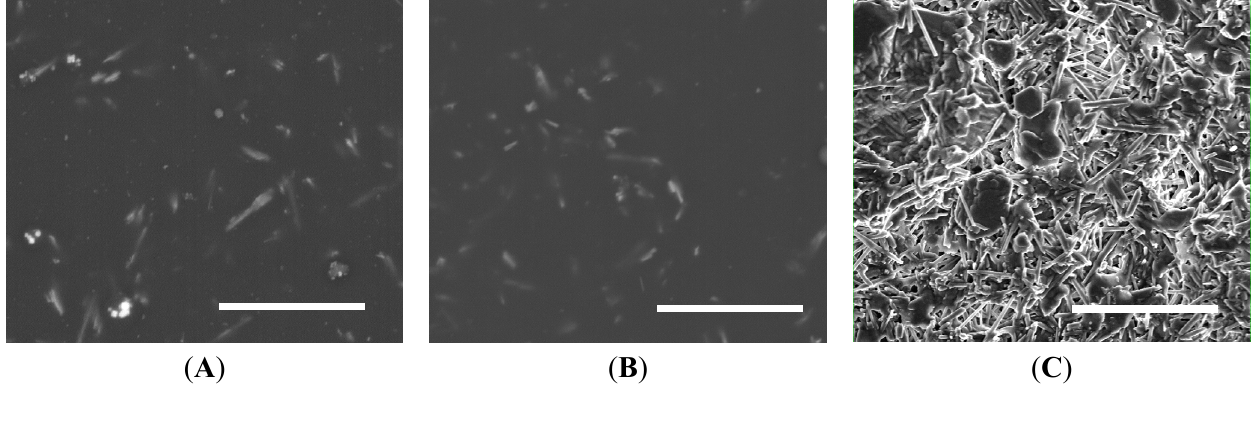
Figure 3. Scanning electron micrographs of films filled with unsilanized HNTs (10 wt%). ( A ) Cast; ( B ) Cast with subsequent ultrasound treatment; ( C ) Sample containing 80 wt% HNTs in an acrylic matrix. Panels A and B suggest that the HNTs are immersed into the bulk of the film. Panel C shows a counter example, where the tubes stick out of the surface. All scale bars correspond to 5 µm. Panel C is reprinted with permission from reference [23] (Copyright 2012, American Chemical